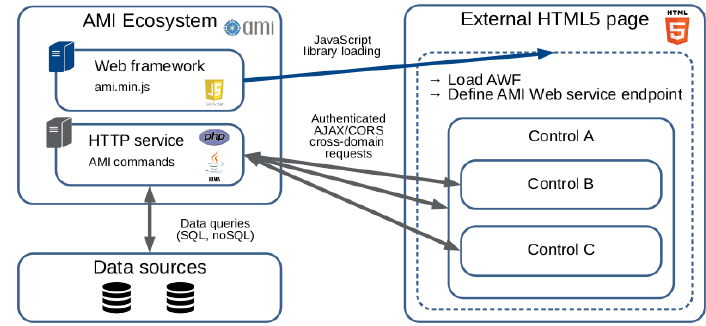
Fig. 2. AWF controls embedded in external Web